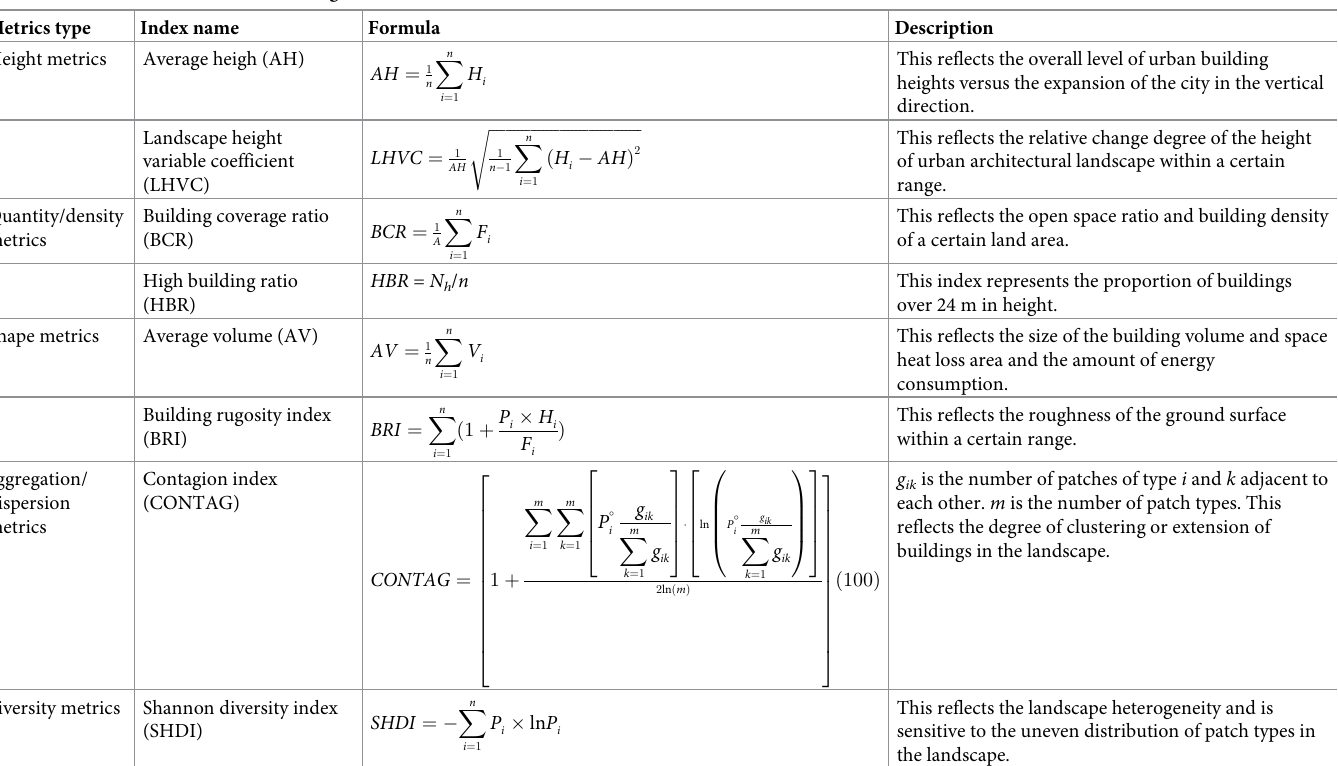
Table 2. Index of terms and their